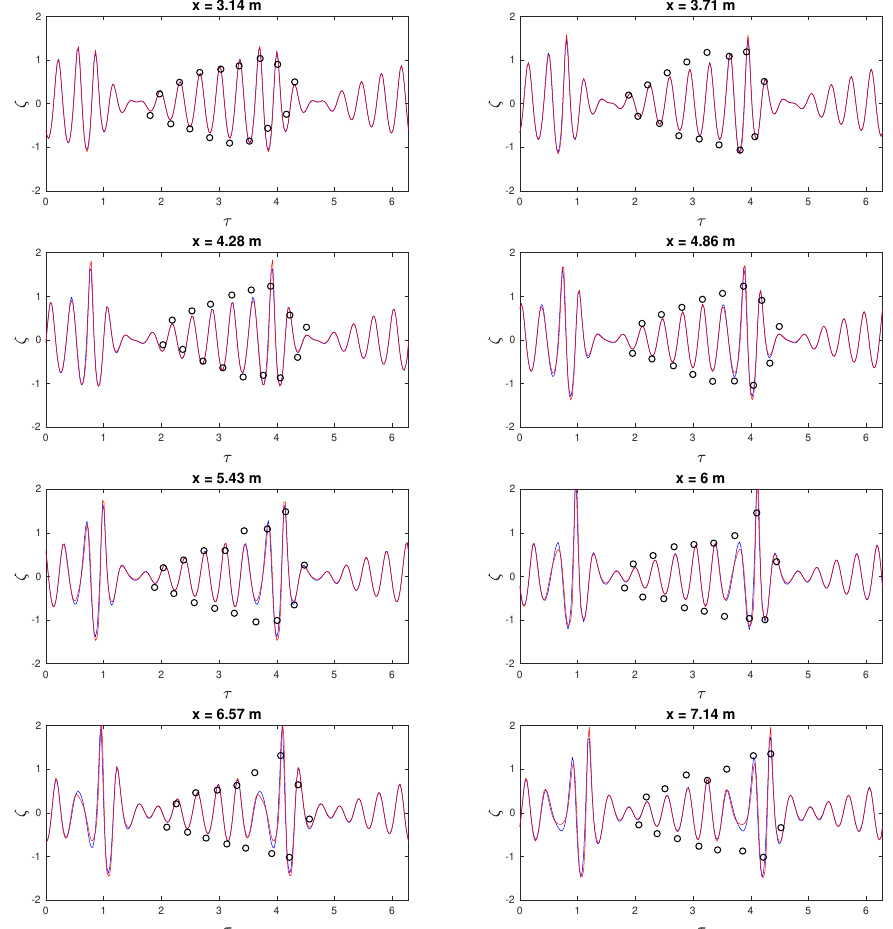
Figure 1. Measured (circles) and computed (lines) surface displacements at 8 stations along the wave tank in Keller’s experiments [42] on periodic groups. The parameters are γ = 0.229, ε = 0.23, k 0 = 8.865 m − 1 . Predictions from our model (blue line) and the spatial form of the classical Dysthe’s equation (red line) are compared. The positions x of the probes are 3.14 m, 3.71 m, 4.28 m, 4.86 m, 5.43 m, 6.00 m, 6.57 m, 7.14